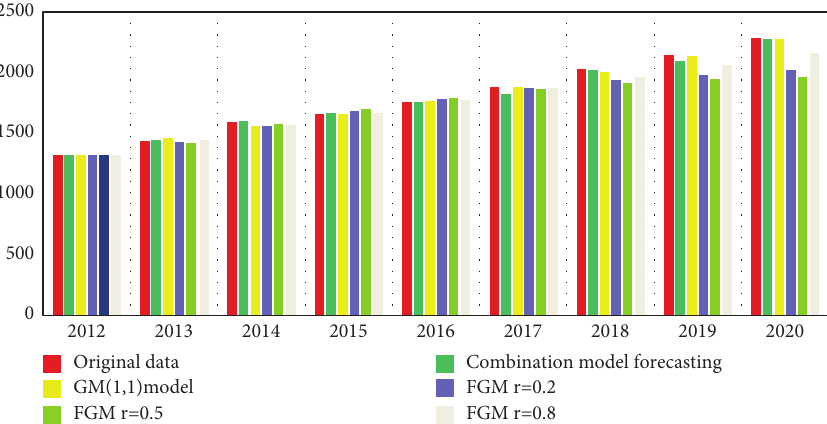
Figure 4: Comparison among original data, the grey combination model, and other grey models (unit: 10,000TEU). Table 7: The forecasting data of the first step using the optimized FGM (1, 1) model (unit: 10,000TEU). Year Tian. r � 1